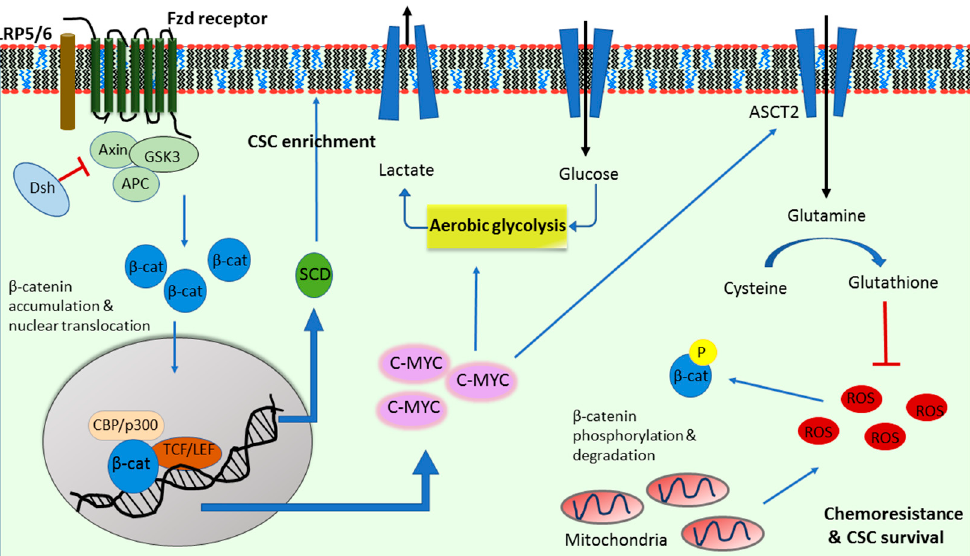
Figure 1. Overview of the role of the canonical Wnt / β -catenin pathway in cancer metabolism. Activation of Wnt signaling requires the binding of Wnt glycoproteins to the frizzled (Fzd) receptor and the low-density lipoprotein receptor-related protein (LRP5 / 6) co-receptor. Receptor activation leads to the inhibition of the destruction complex, Axin2 / APC / GSK3 through the recruitment of disheveled (Dvl). β -catenin can then accumulate in cytoplasm and translocate to the nucleus where the TCF / LEF family of transcriptional factors activate a wide range of Wnt target genes. Through c-MYC, Wnt controls the increased aerobic glycolysis, glutamine transporter ASCT2 levels and subsequent glutathione (GSH) production, which is implicated in cancer chemoresistance and cancer stem cell (CSC) survival via the inhibition of reactive oxygen species (ROS). Wnt also upregulates stearoyl-CoA desaturase-1 (SCD), in particular SCD1, which has been considered as the hallmark for CSC enrichment.